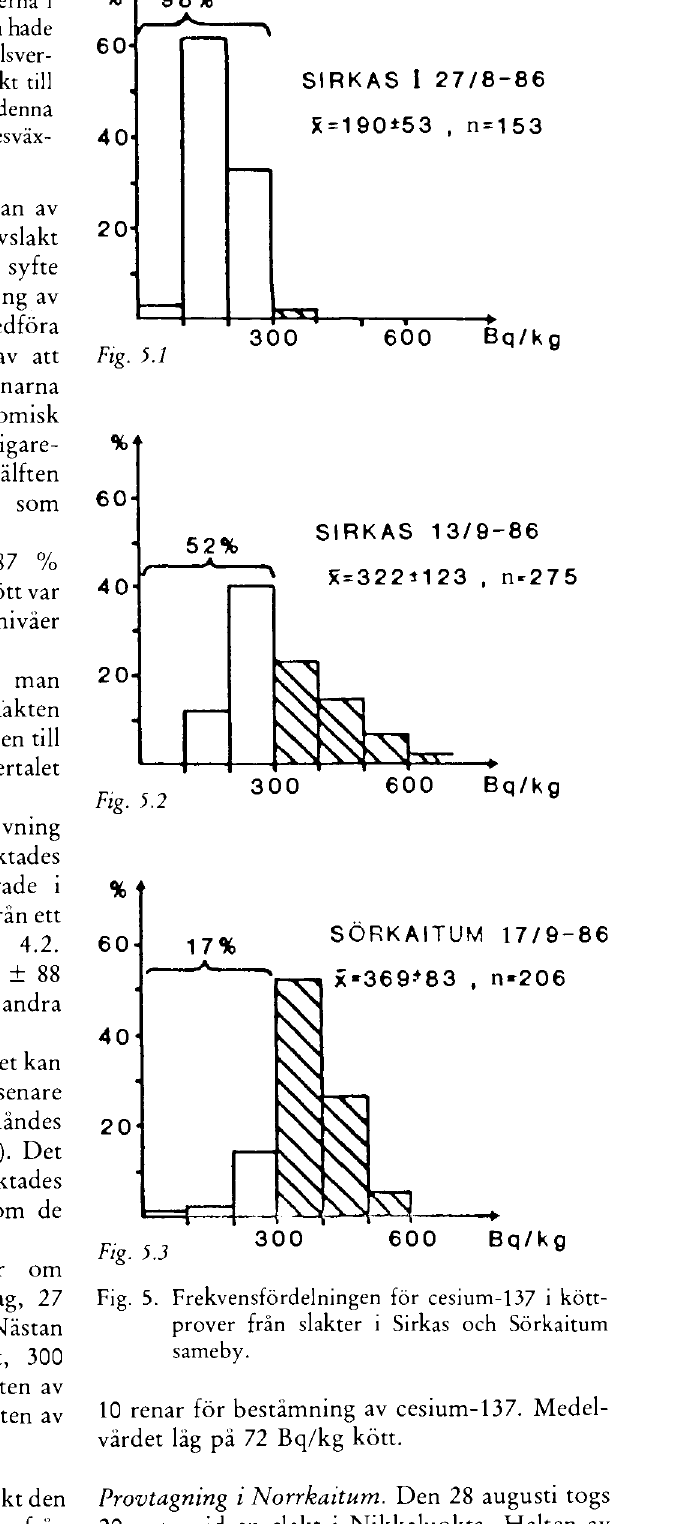
Fig. 5. Frekvensfordelningen for cesium-137 i kott- prover från slakter i Sirkas och Sorkaitum sameby. 10 renar for beståmning av cesium-137. Medel vårdet låg på 72 Bq/kg kott. Provtagning i Norrkaitum. Den 28 augusti togs 20 prov vid en slakt i Nikkaluokta. Halten